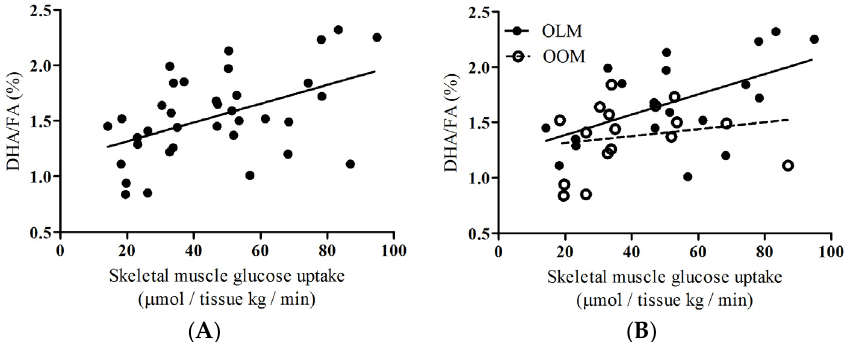
Figure 2. Correlations of DHA/FA ratios (percentages) to skeletal muscle glucose uptake between OOM and OLM groups. ( A ) In the whole group, Spearman’s rho value was 0.444 ( p = 0.007). n = 36; ( B ) Spearman’s rho value for OLM group was 0.496 ( p = 0.031) and for OOM group was − 0.165. OLM: n = 19; OOM: n = 16.